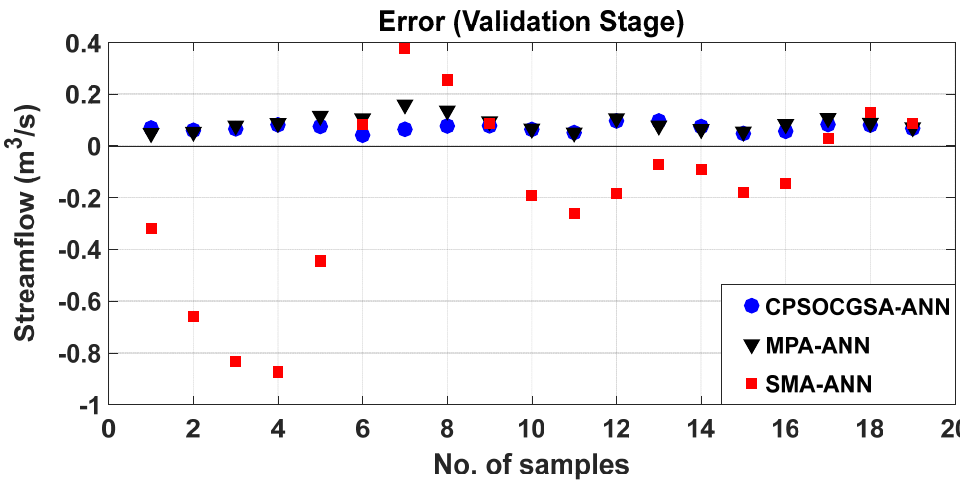
Figure 9. CPSOCGSA-ANN, MPA-ANN, and SMA-ANN residual